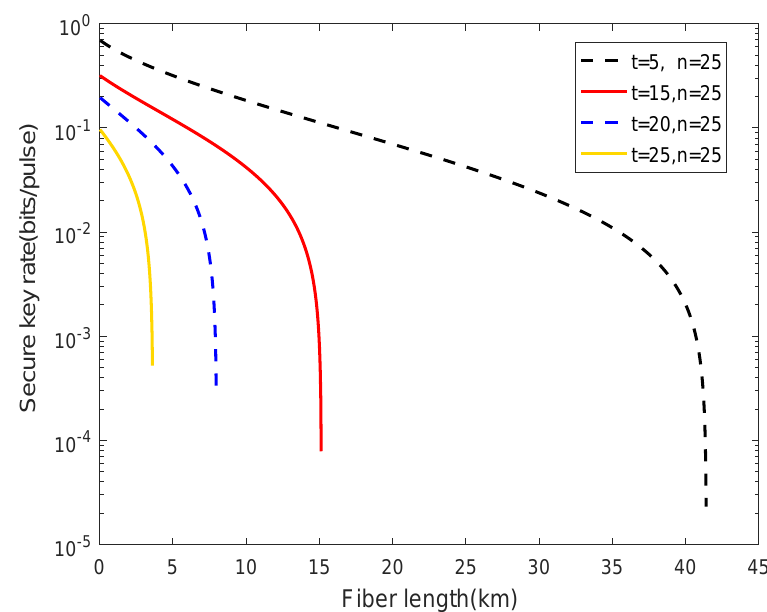
Figure 4. The secure rates of different number of legitimate participants for n = 25. The parameters are given by V A = 6, γ = 0.2 dB/km, ε = 0.01, κ = 0.98, η = 0.6, and v el = 0.01.